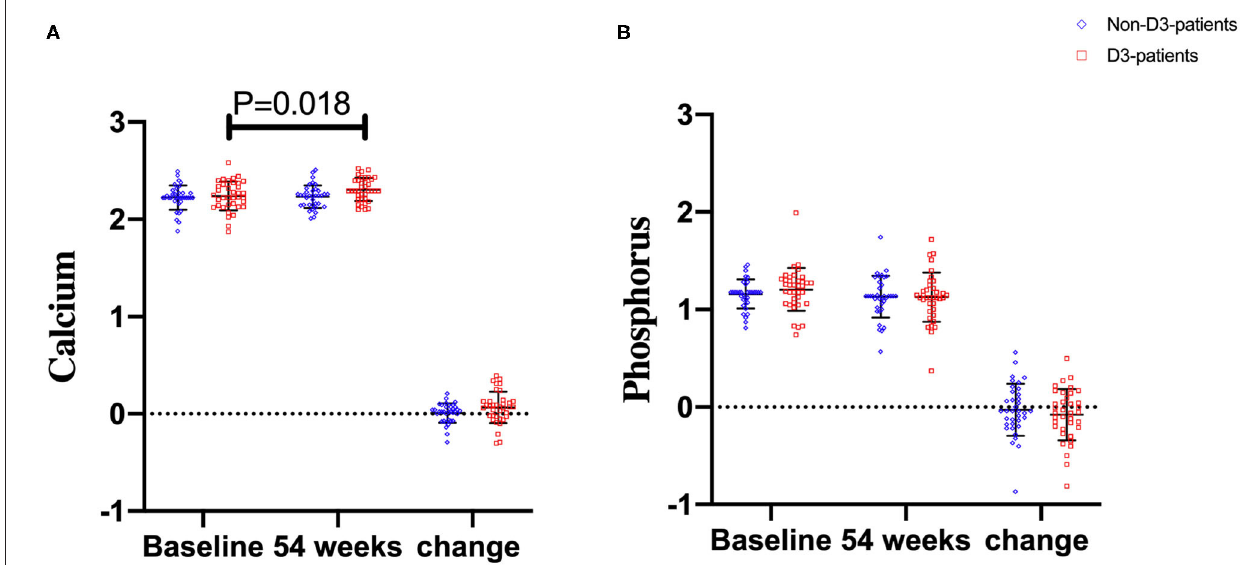
FIGURE 5 | The changes of calcium and phosphorus levels between baseline and week 54 in CD patients receiving IFX therapy. (A) Calcium levels. (B) Phosphorus